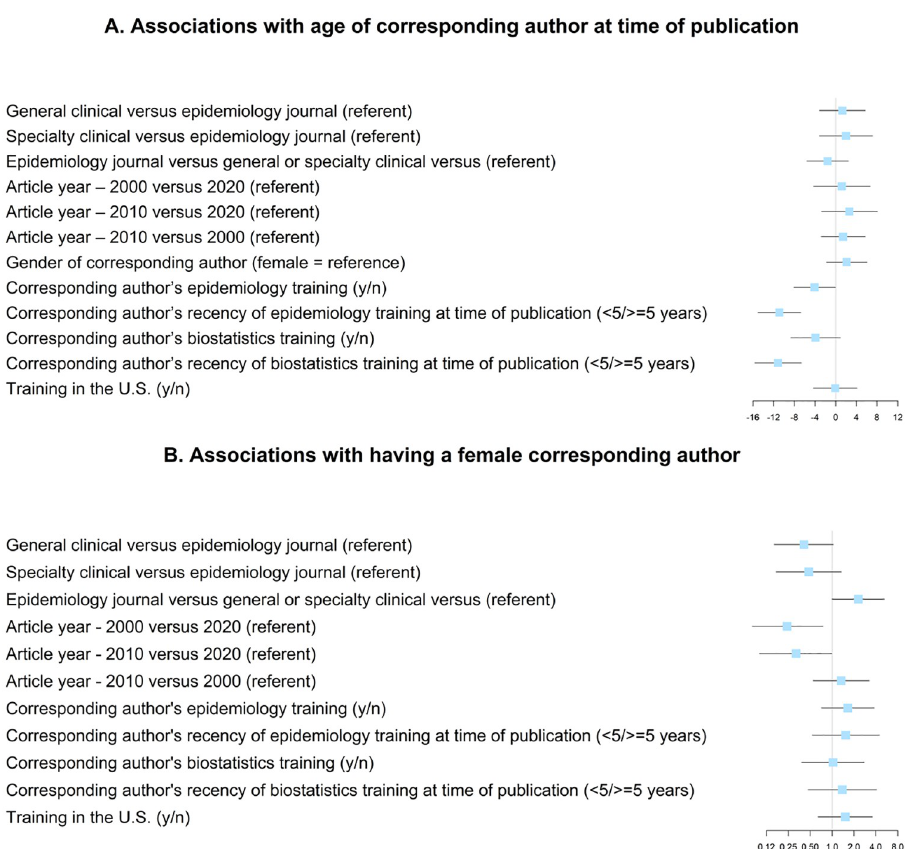
Fig 2. Bivariate associations with (A) age of corresponding author at time of publication and (B) having a female corresponding author. Boxes represent betas (panel A) or odds ratios (panel B). Lines represent 95% confidence